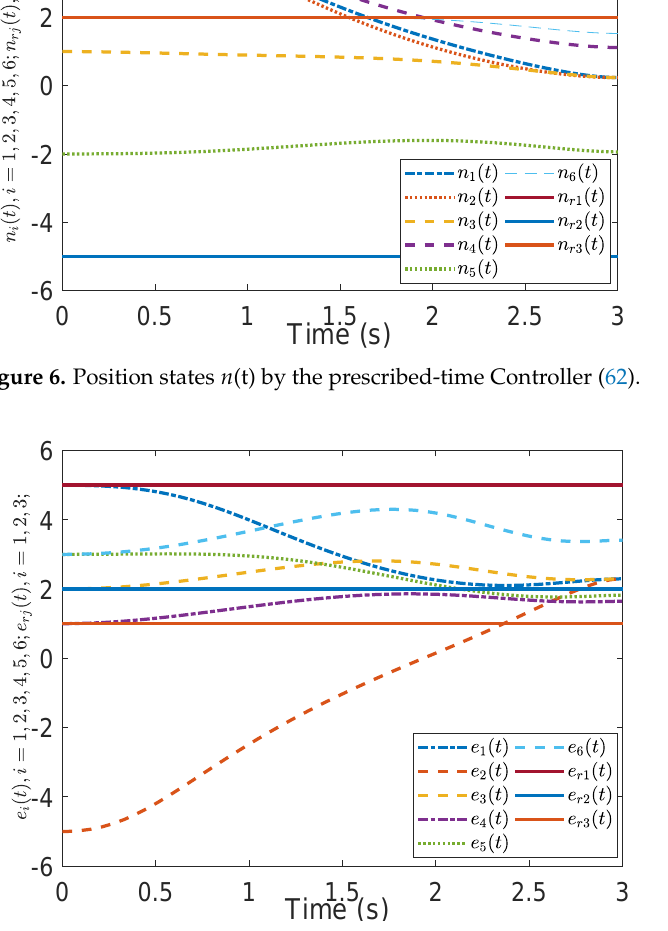
Figure 7. Position states e (t) by the prescribed-time Controller